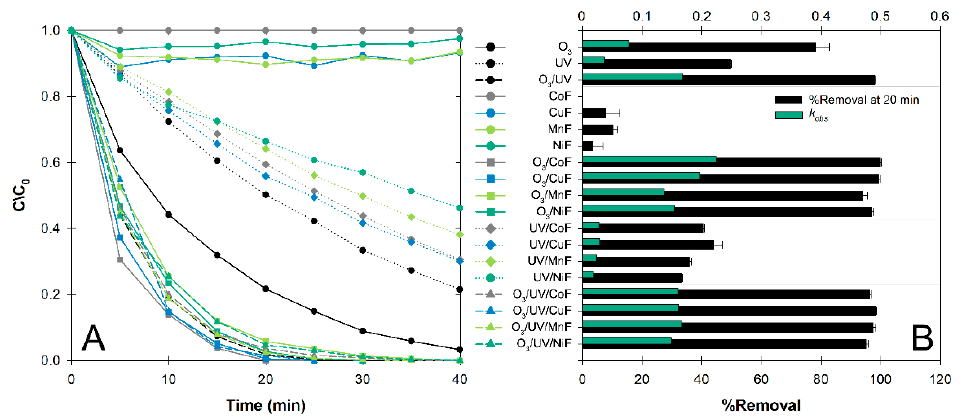
Figure 1. Degradation of butylparaben (BP) under different treatment systems: ( A ) degradation ki- netics, and ( B ) observed rate constant ( k obs ) and %removal at 20 min (Catalyst: 0.2 g L − 1 , [BP o ]: 10 µM, pH 7, 25 °C). Error bars indicate ± standard deviation.